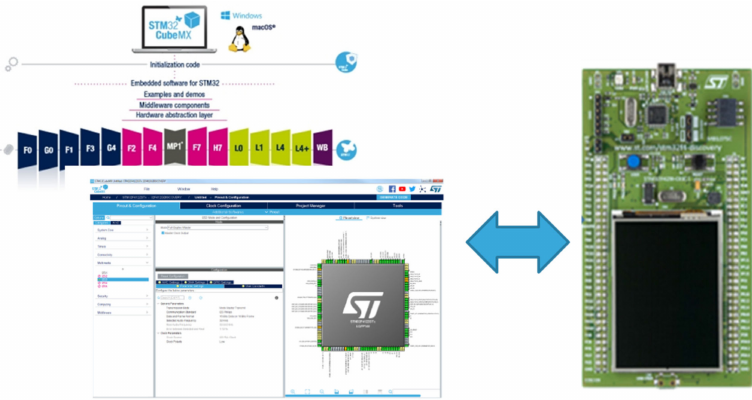
Figure 11. The STM32 embedded platform for hosting the proposed pipeline as